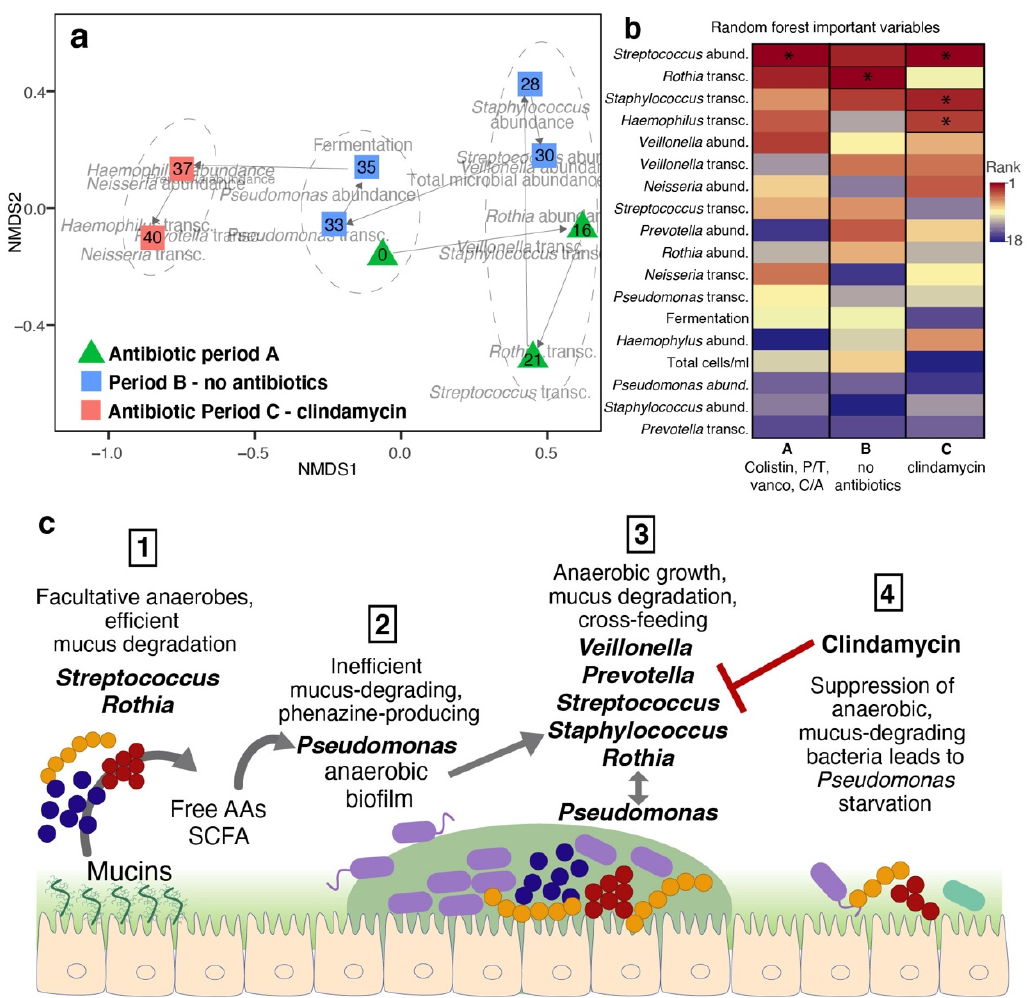
Figure 3. Microbial community succession. ( a ) Non-metric multidimensional scaling (NMDS) of sputum samples over time. The variables used as input for the NMDS were fermentation, total microbial abundances, genera-specific microbial abundances, and genera-specific transcriptomic activity. Symbols are color-coded by antibiotic treatment periods (green: A—colistin, vancomycin, ceftazidime-avibactam, and piperacillin-tazobactam; blue: B—no antibiotics; pink: C—clindamycin), and numbers inside the symbols indicate days since hospital admission event when Rapid Response was initiated. The dotted ellipses indicate health status groups supported by an unsupervised random forest analysis followed by clustering using Ward distances (out of bag error = 11.1%). ( b ) Important variables differentiating treatment periods in a classification random forest analysis supervised by treatments. The variables marked by an asterisk and surrounded by a black box indicate variables with p -values less than 0.05 in the permutational test. ( c ) Conceptual model of succession events in patient CF146: (1) The mucosal surfaces are colonized by facultative anaerobes, including Streptococcus sp. and Rothia sp., capable of efficient mucus degradation producing free-amino acids and short-chain fatty acids (SCFA, i.e., propionate, acetate, butyrate, and butanediol). (2) The free amino acids and SCFAs open a niche for the growth of P. aeruginosa , which degrades mucins poorly. P. aeruginosa grows forming an anaerobic biofilm and produces phenazines. (3) The P. aeruginosa biofilm facilitates the growth of obligate anaerobes such as Veillonella sp. and Prevotella sp. There is an overall growth of the whole microbial community, with Pseudomonas benefitting from the metabolic products from anaerobes. (4) The onset of clindamycin treatment suppresses the growth of Gram-positive anaerobes, such as Streptococcus sp. and Staphylococcus sp. The suppression of mucus-degrading bacteria removes the main nutritional source for P. aeruginosa , leading to an overall decrease in microbial abundances. Period A corresponds to 28 days of hospitalization when the patient was treatment with colistin, vancomycin, piperacillin-tazobactam, and ceftazidime-avibactam; in period Period B the patient was released and was off antibiotics; Period C is the clindamycin